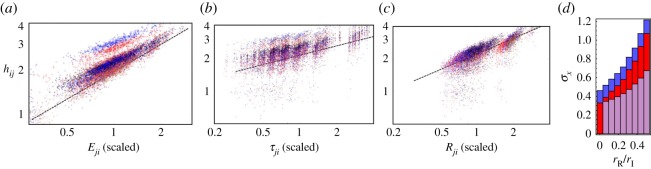
Inclusion of low-degree nodes in the prediction of hij in the fitting reduces the quality of the agreement for all measures of topological closeness for N = 512 and 〈k〉 = 4. In (a), low-degree nodes tend to become infected slower than would be predicted by the GENs, leading to significant weight far from the fit. (b,c) The quality of the fit for the MFPT and resistance distance (respectively). In (d), the poorness of the fit is quantified using the standard deviation. At rR → 0 the GENs perform best, but resistance distance is a better predictor of infection time for larger rR. Note the change in scale from figure 4f.